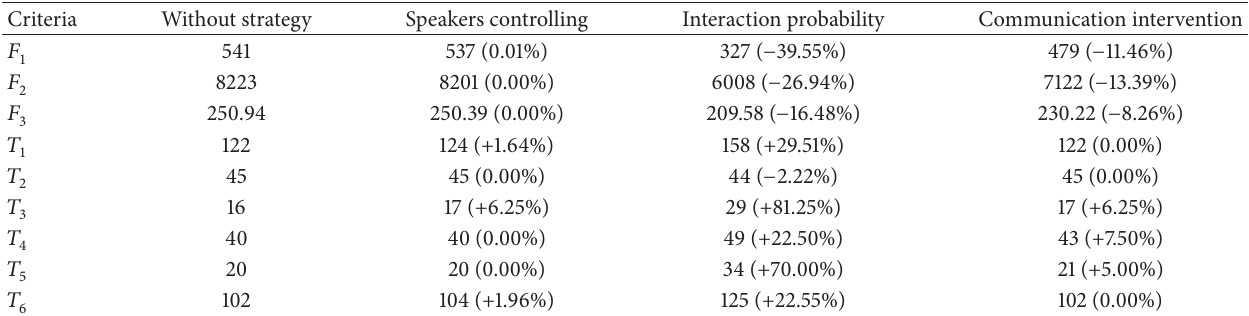
Table 2: Strategy effectiveness results of single